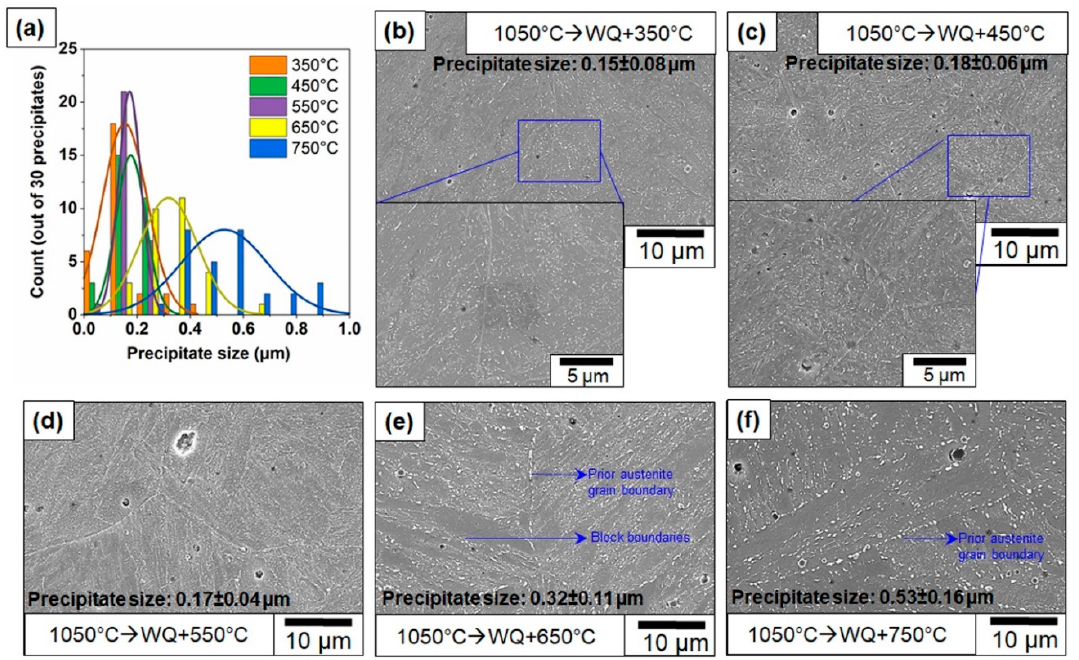
Figure 13. ( a ) Histogram of precipitate counts in different temperature tempered samples and scanning electron micrographs showing precipitates in samples with tempering temperature; ( b ) 350 ◦ C; ( c ) 450 ◦ C; ( d ) 550 ◦ C; ( e ) 650 ◦ C; ( f ) 750 ◦ C.